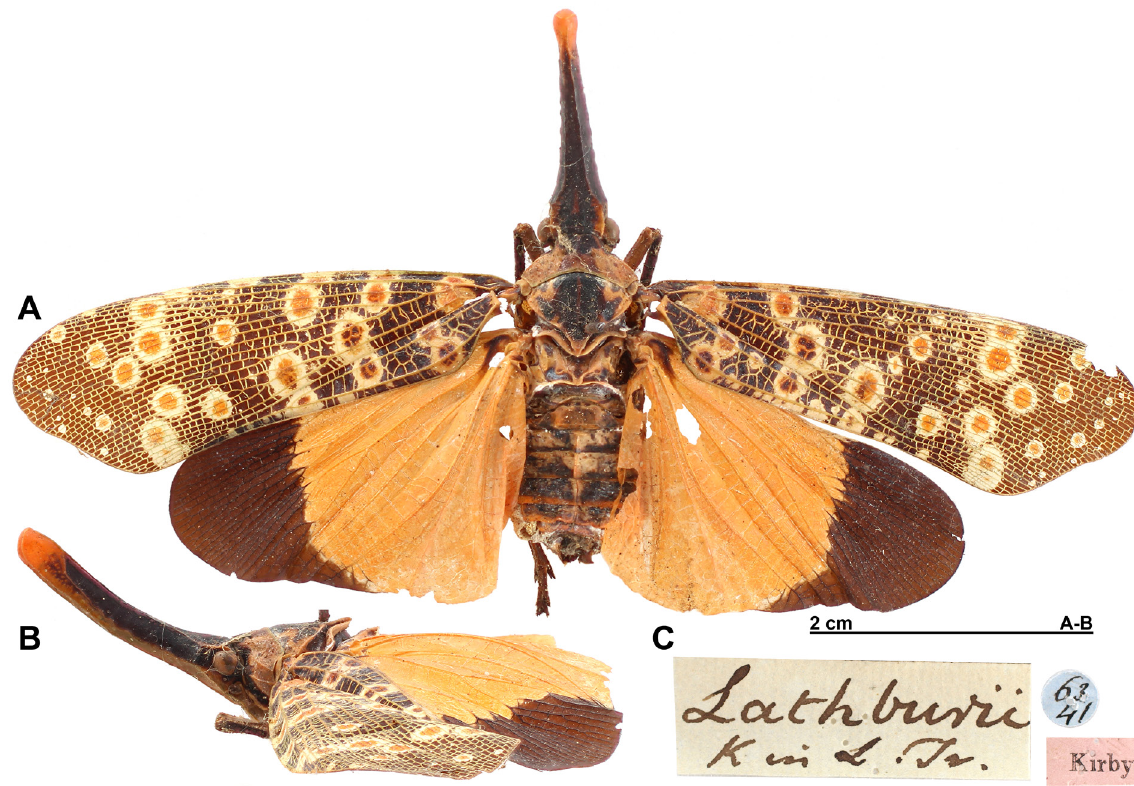
Fig. 6. Pyrops lathburii (Kirby, 1818), lectotype ♀ (BMNH). A . Habitus, dorsal view. B . Habitus, lateral view. C .